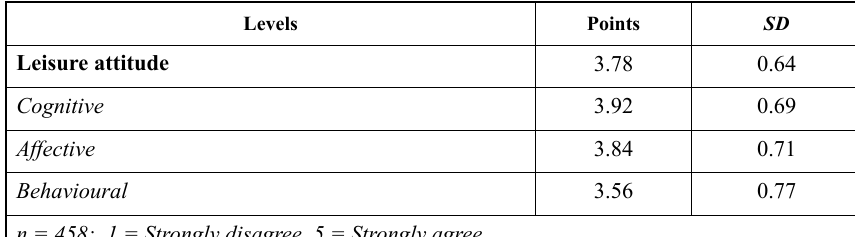
Table 2. Leisure attitude levels of the participants